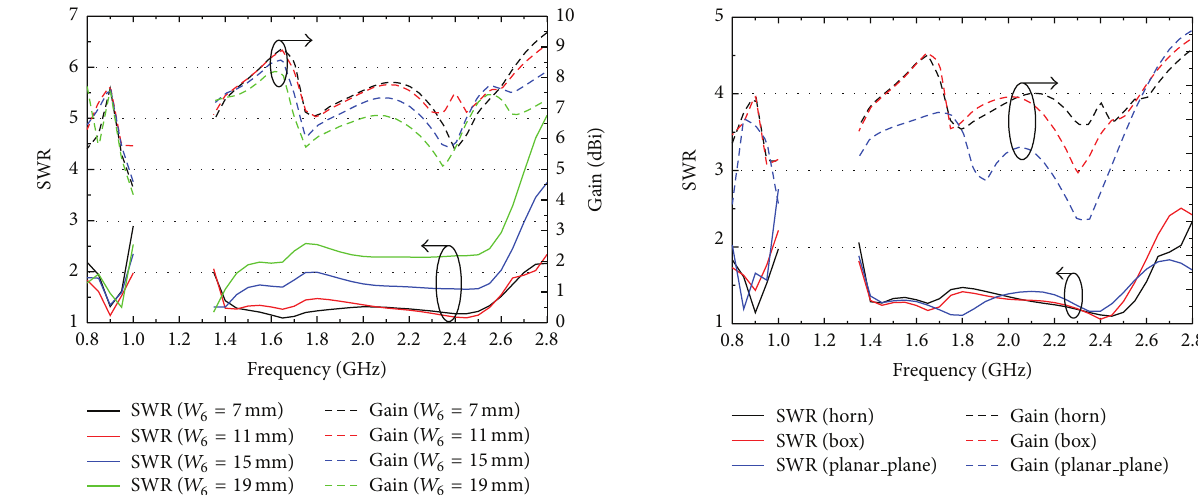
Figure 7: Effects of the 𝑊 6 while keeping 𝐿 11 = 8 mm.